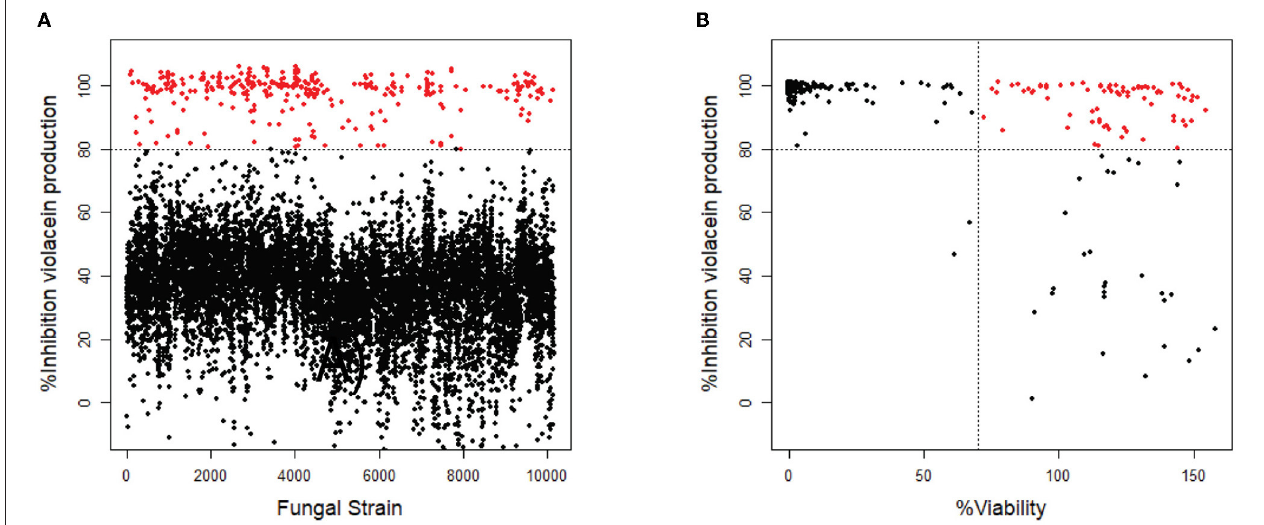
FIGURE 1 | Screening of fungal secondary metabolites on C. violaceum reporter. (A) Inhibition of violacein production after treatment with fungal supernatant. Every dot represents the supernatant of a single fungal strain. Fungal supernatants that show inhibition of more than 80% are shown as red dots ( N = 324). (B) The 324 strains that showed inhibition of > 80% were screened again, measuring both inhibition of violacein production and the viability of the bacteria. The compounds that show inhibition of > 80% while not affecting the viability ( > 70%) are shown as red dots ( N =